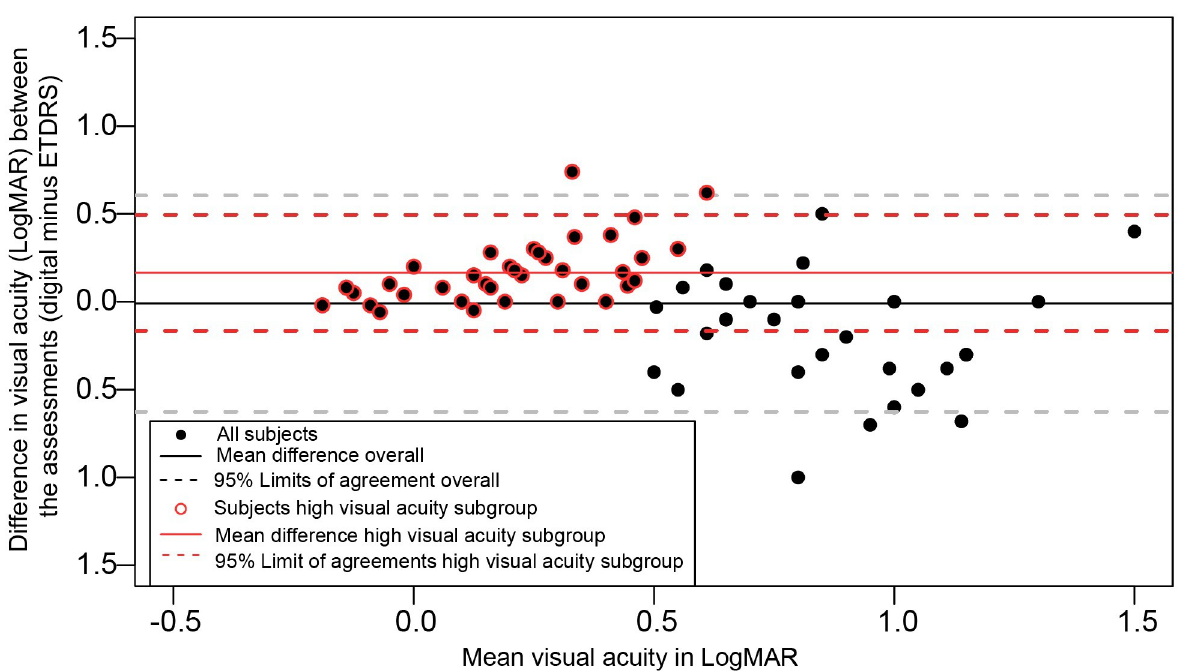
Fig 2. A Bland-Altman plot displaying the differences in logarithmic minimum angle of resolution (LogMAR) between the web-based uncorrected distance visual acuity assessment (index test) and the ETDRS uncorrected distance visual acuity measurement (reference test). The differences between the reference test and index test shown on the Y-axis are expressed as the difference of the web-based uncorrected distance visual acuity assessment outcome minus the ETDRS uncorrected distance visual acuity outcome. The x-axis shows the mean visual acuity in LogMAR of the two assessments, where a more negative value represents a higher visual acuity. The outcome is stratified for a ‘better visual acuity’ subgroup (uncorrected distance visual acuity � 0.5 LogMAR) highlighted with a red circle.